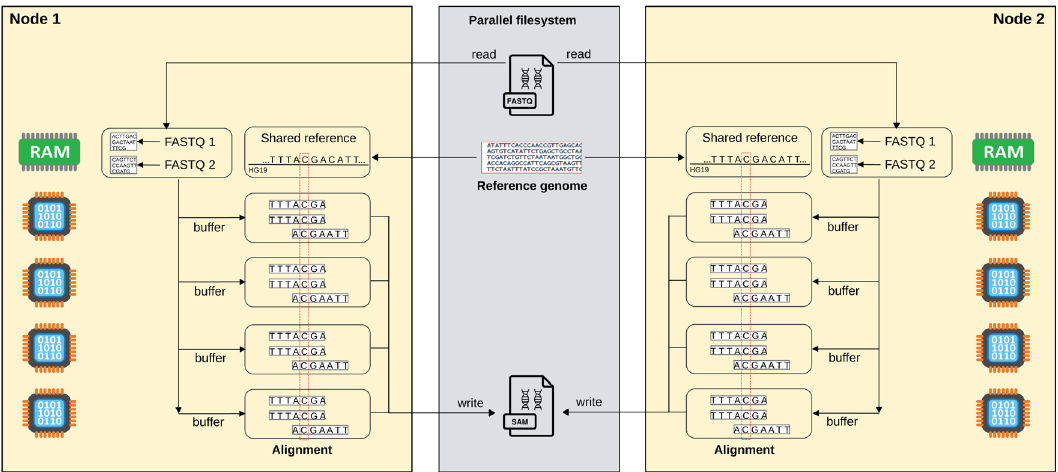
Figure 1. Alignment with mpiBWA using two computing nodes and four cores per node. Each core is in charge of aligning a chunk of the FASTQ file. The reference genome is stored in shared memory of each node of the computing cluster. Once aligned, the results are written into a SAM file. To ensure scalability, the read and write operations require a parallel filesystem.